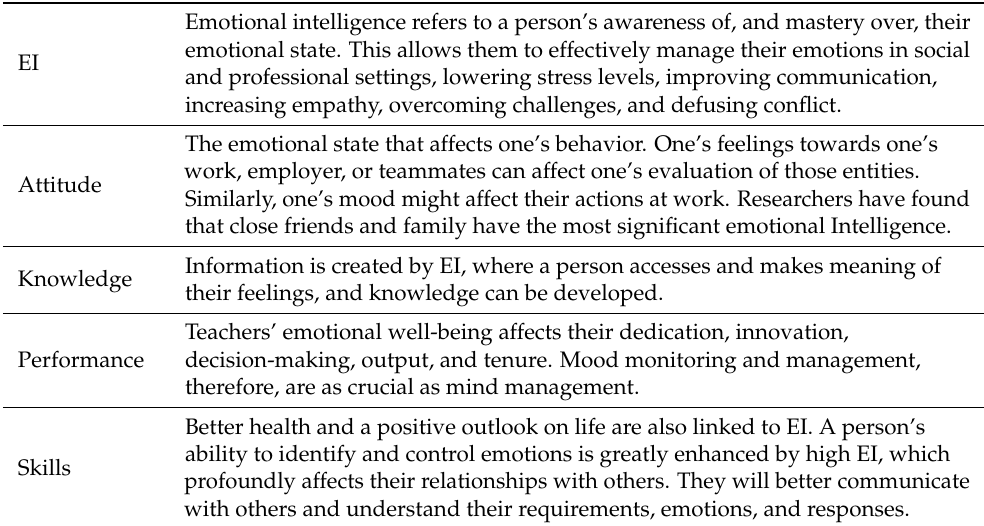
Table 2. Variable